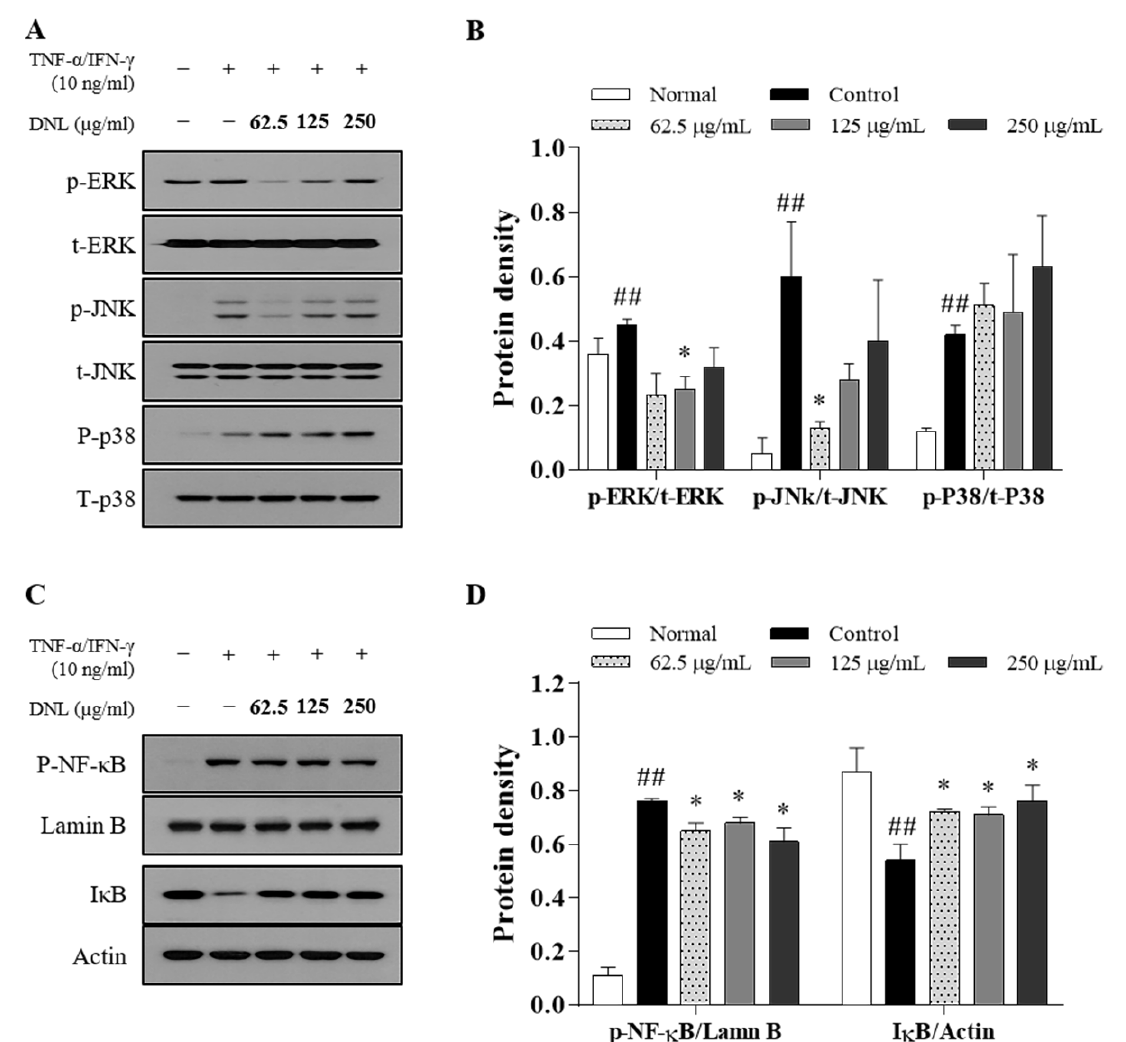
Figure 7. Effect of DNL on protein expression of MAPK and NF- κ B/I κ B in TNF- α /IFN-induced HaCaT cells. ( A ) MAPK protein expression in TNF- α /IFN- γ -induced HaCaT cells was confirmed by Western blot. ( B ) p-ERK, p-JNK, and p-p38 were normalized using the ImageJ program by T-ERK, t-JNK, and t-p38, respectively. ( C ) The phosphorylation of the signaling pathway of NF- κ B/I κ B in TNF- α /IFN- γ -induced HaCaT cells was confirmed by Western blot. ( D ) Phosphorylation of p-NF- κ B was normalized by Lamin B, and I κ B was normalized by Actin. Normalization was performed through the ImageJ program. The data are expressed as mean ± SEM ( n = 3). ## p < 0.01, compared with the normal group. * p < 0.05 compared with the control group.